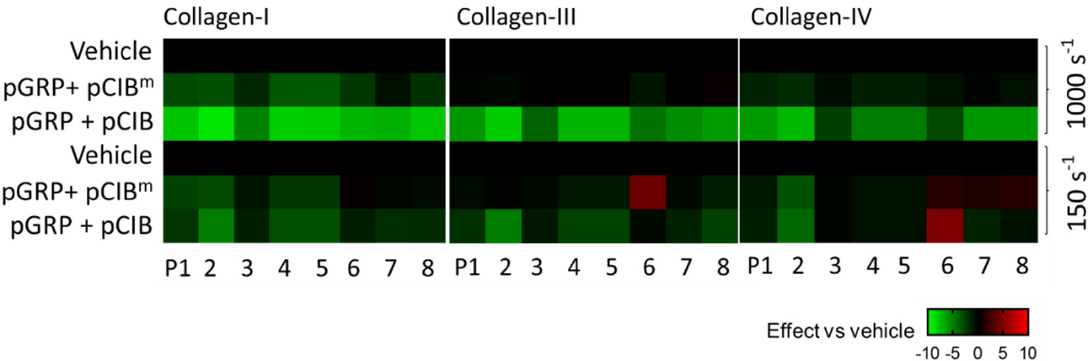
Figure 7. Shear rate dependency of GPR56 and CIB1 peptides. Blood samples pre-incubated with vehicle (control) or indicated peptides (50 µ g/mL) for 10 min and then perfused over collagen microspots for 3.5 min at 1000 s − 1 or for 6 min at 150 s − 1 . Shown is the subtraction heatmap representing control-subtracted scaled (0–10) image parameter values for collagen I, III, and IV microspots. The color code represents a decrease (green) or increase (red) in comparison to vehicle control runs.